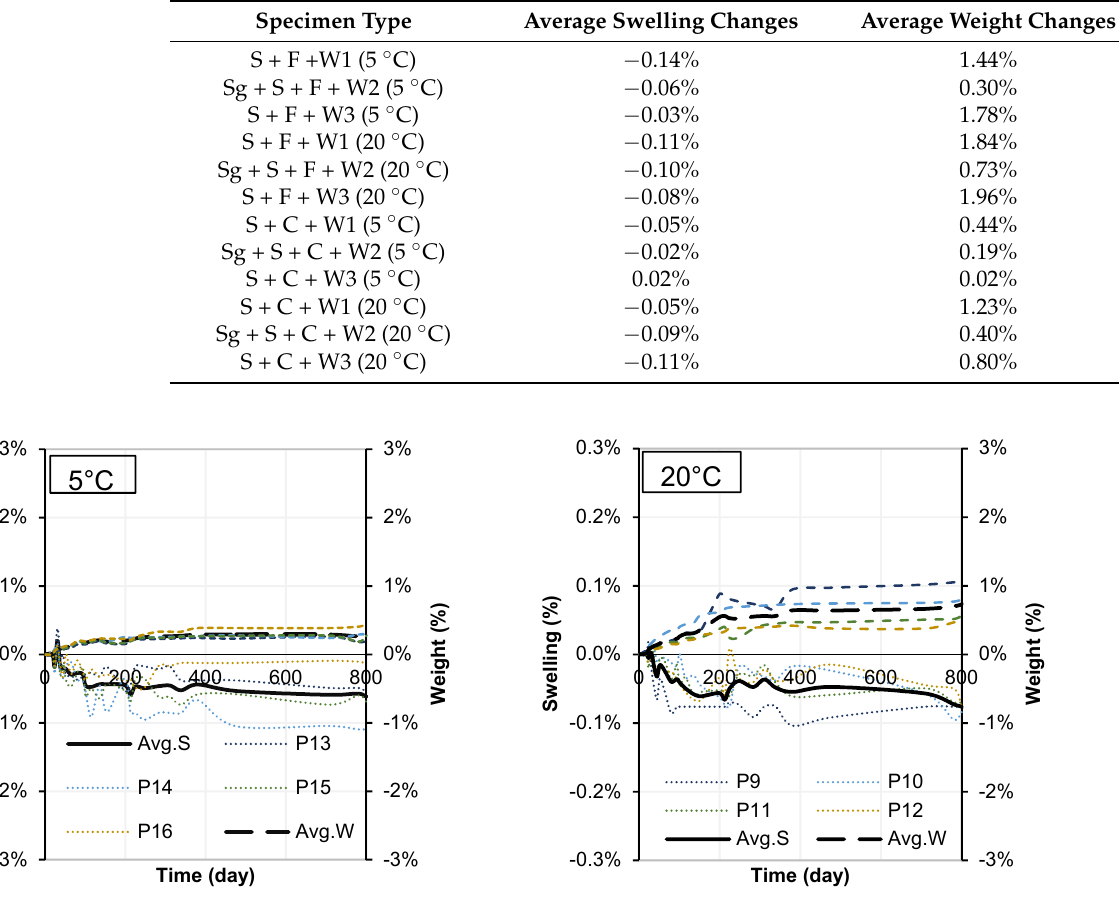
Figure 10. Swelling results in Sg + S + F + W2 at different temperatures.